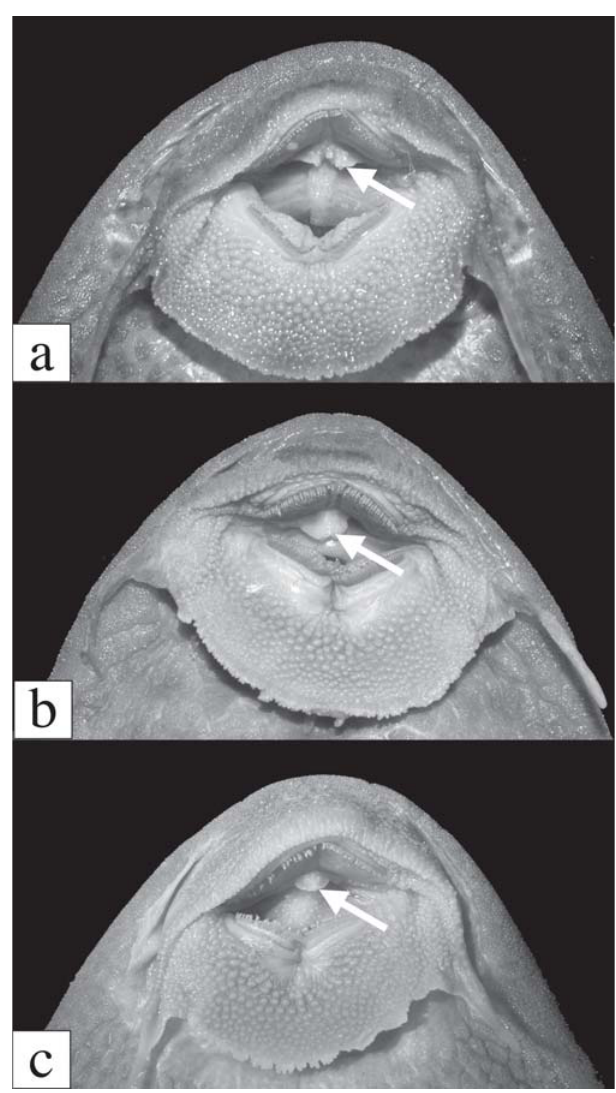
Fig. 1. Mouth and buccal papilla (indicated by arrow) of a. Pterygoplichthys punctatus , MCP 35755, 203.1 mm SL, b.